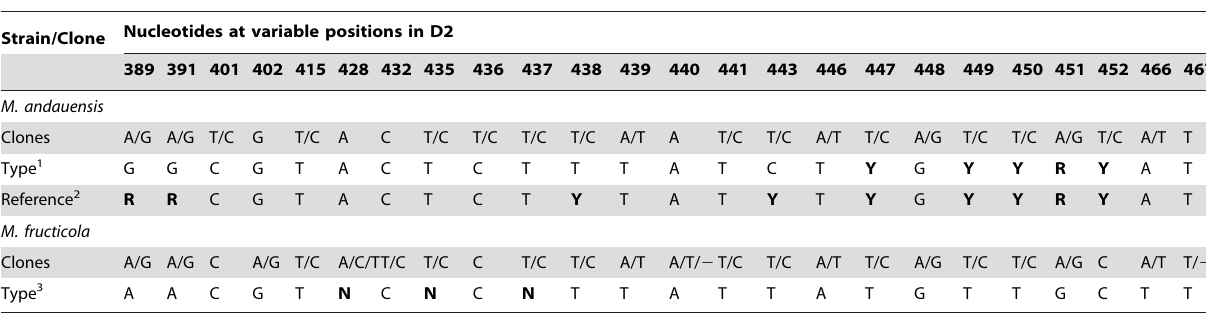
Table 3. Nucleotides at variable positions in the D2 domain.